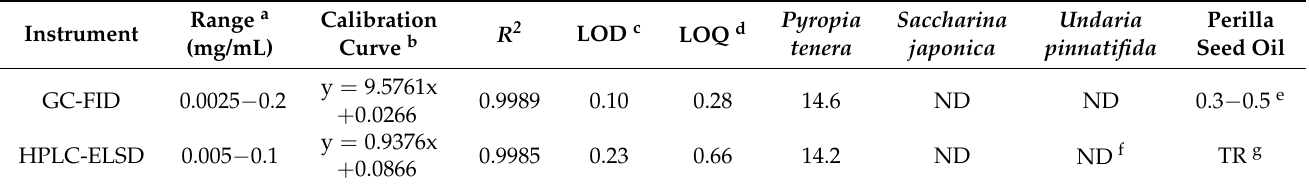
Table 1. Cholesterol contents (mg/100 g) in Pyropia tenera, Saccharina japonica, Undaria pinnatifida , and perilla seed oil obtained by gas chromatography-flame ionization detection (GC-FID) and high-performance liquid chromatography-evaporative light-scattering detection